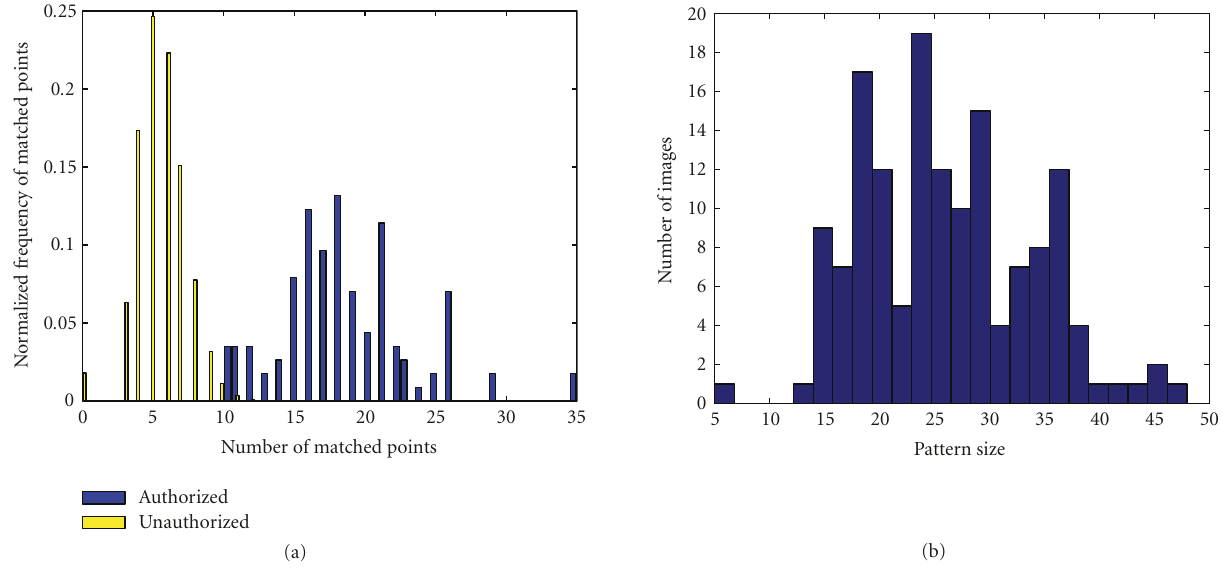
Figure 10: (a) Matched points histogram in the attacks (unauthorised) and clients (authorised) authentications cases. In the interval [10,13] both distributions overlap. (b) histogram of detected points for the patterns extracted from the training set.